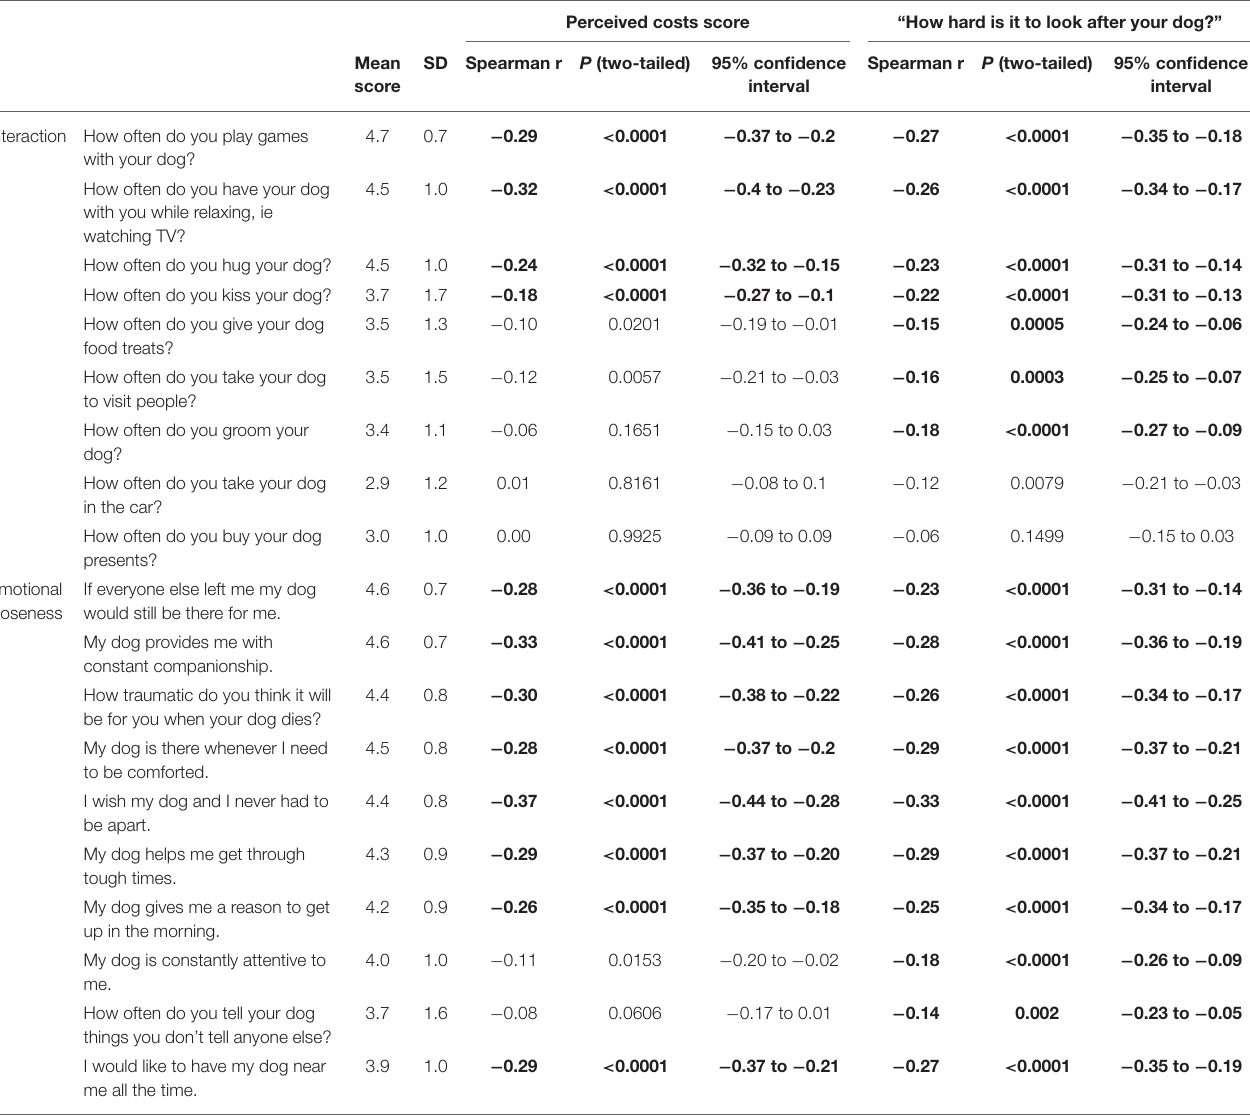
TABLE 2 | Correlations between individual MDORS items and the scores for perceived costs and “How hard is it to look after your dog” (representative sample). Perceived costs score “How hard is it to look after your dog?” Mean SD Spearman r P (two-tailed) 95% confidence Spearman r P (two-tailed) 95% confidence score interval interval Interaction How often do you play games with your